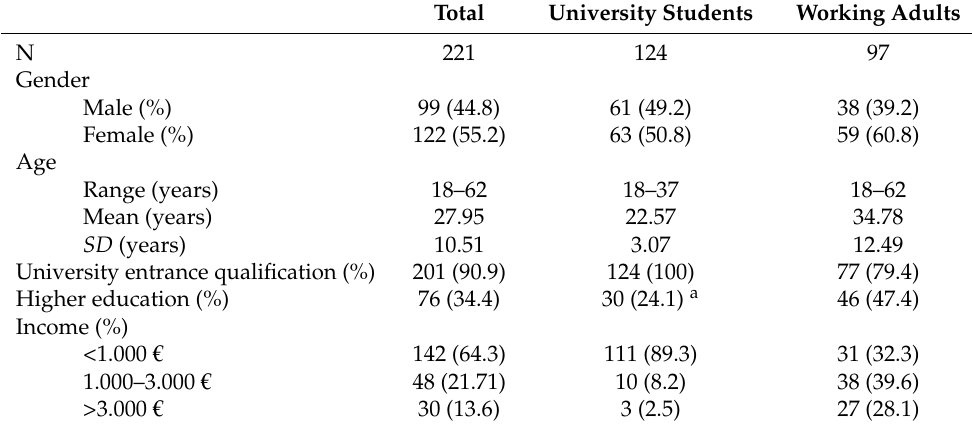
Table 1. Demographic characteristics of the examined